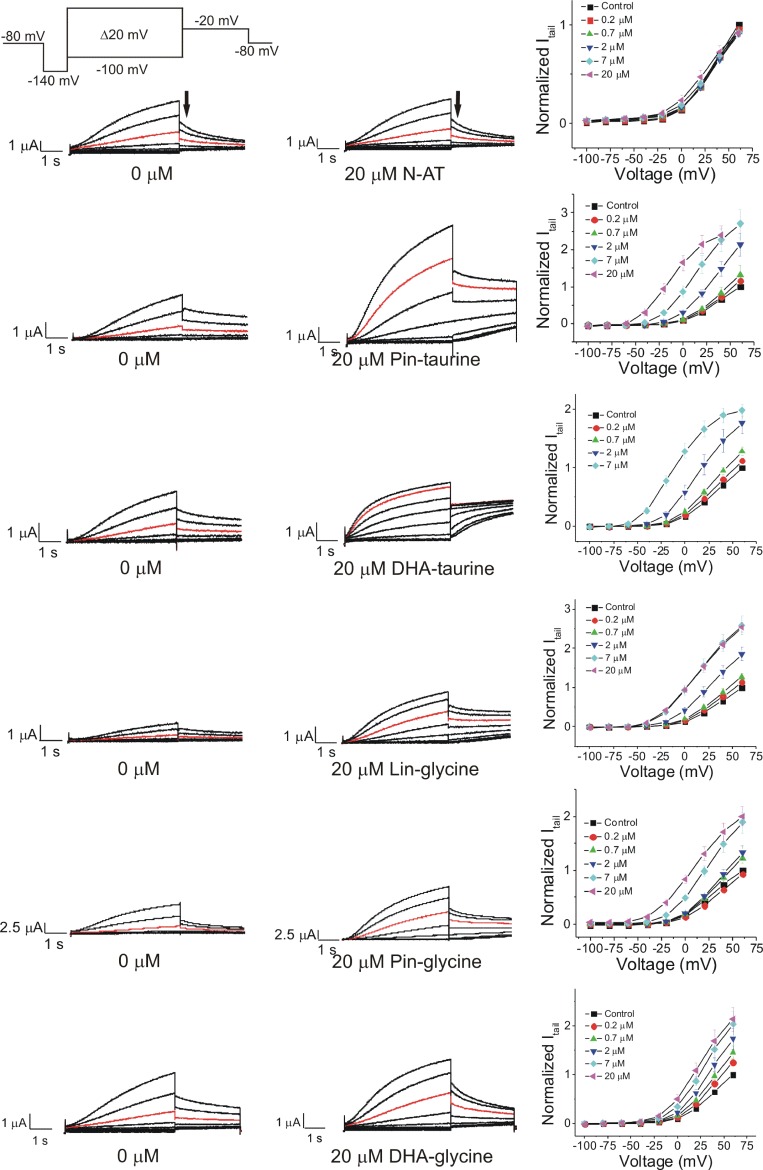
Raw current traces for PUFA analogues on Kv7.1/KCNE1.Kv7.1/KCNE1 raw current traces in control (0 μM) (left) and 20 μM (middle) PUFA analogues, followed by current-voltage (I–V) relationship (right) for each PUFA analogue tested. Voltage protocol (top) overlaps with current traces to illustrate time points during the voltage steps. Arrows over top trace represent the point at which tail currents are measured for generation of current-voltage (I–V) relationship. Red traces represent the current that occurs at a voltage step to 20 mV.